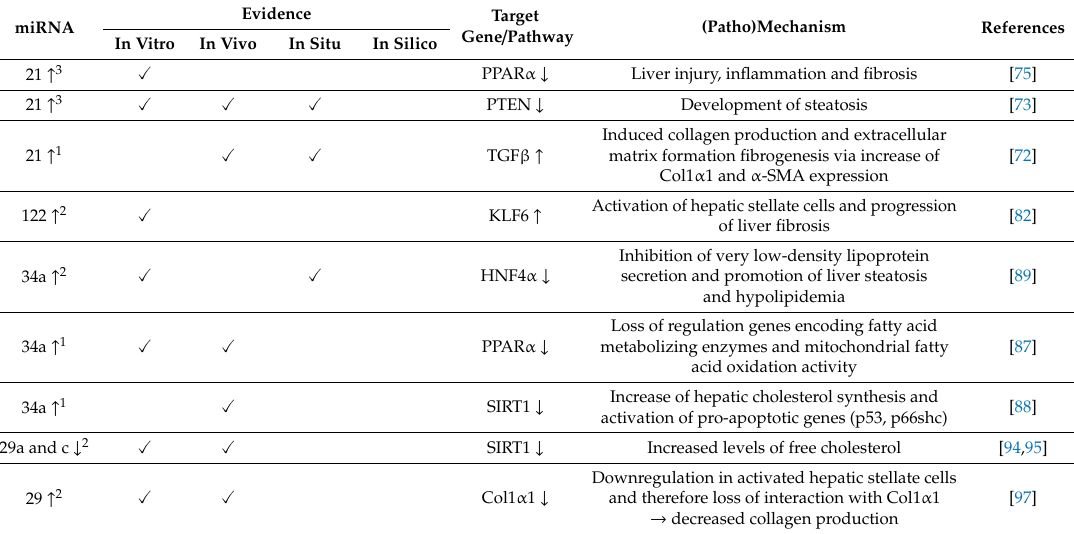
Table 3. Deregulated miRNAs and relation to OS in NAFLD /